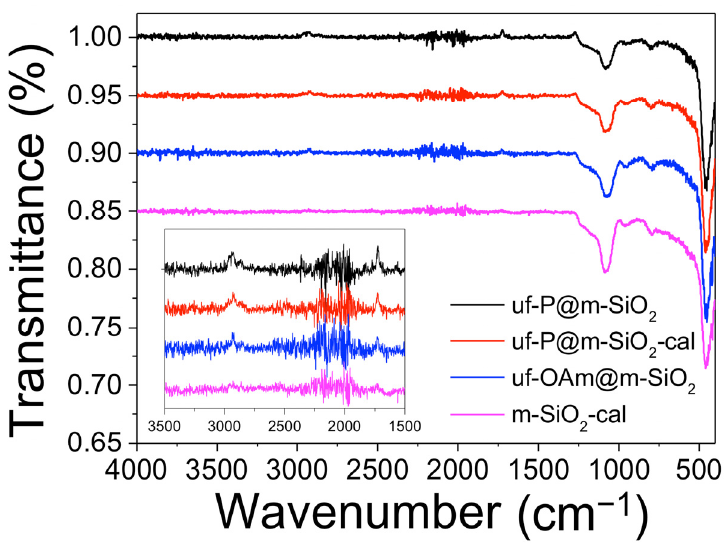
Figure 2. Fourier transform infrared (FTIR) spectra of uf-P@m-SiO 2 , uf-P@m-SiO 2 -cal, uf-OAm@m- SiO 2 , and m-SiO 2 -cal samples.